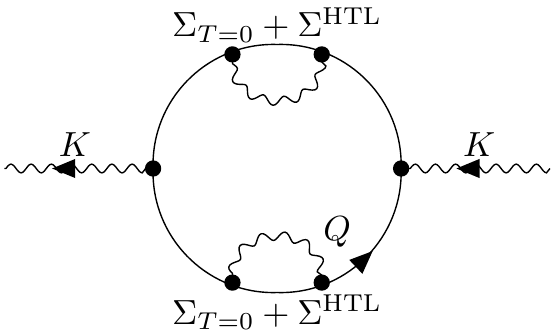
Figure 5. A three-loop contribution to the polarization tensor Π ( 3 ) ( k 0 , k , T )